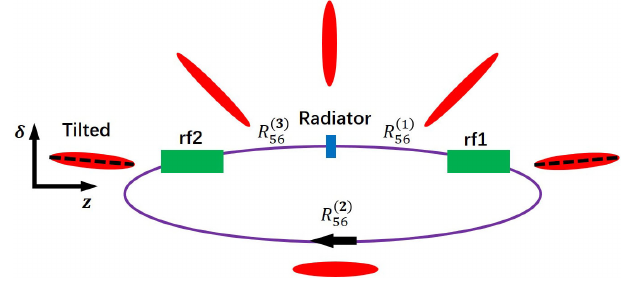
FIG. 4. Schematic layout of a storage ring using two rf systems for longitudinal strong focusing and an example beam distribu- tion evolution in the longitudinal phase space. Note that the tilted angles of the beam distribution and bunch length ratios at different places do not strictly correspond to the parameters in Table II but only to present the qualitative characteristics.